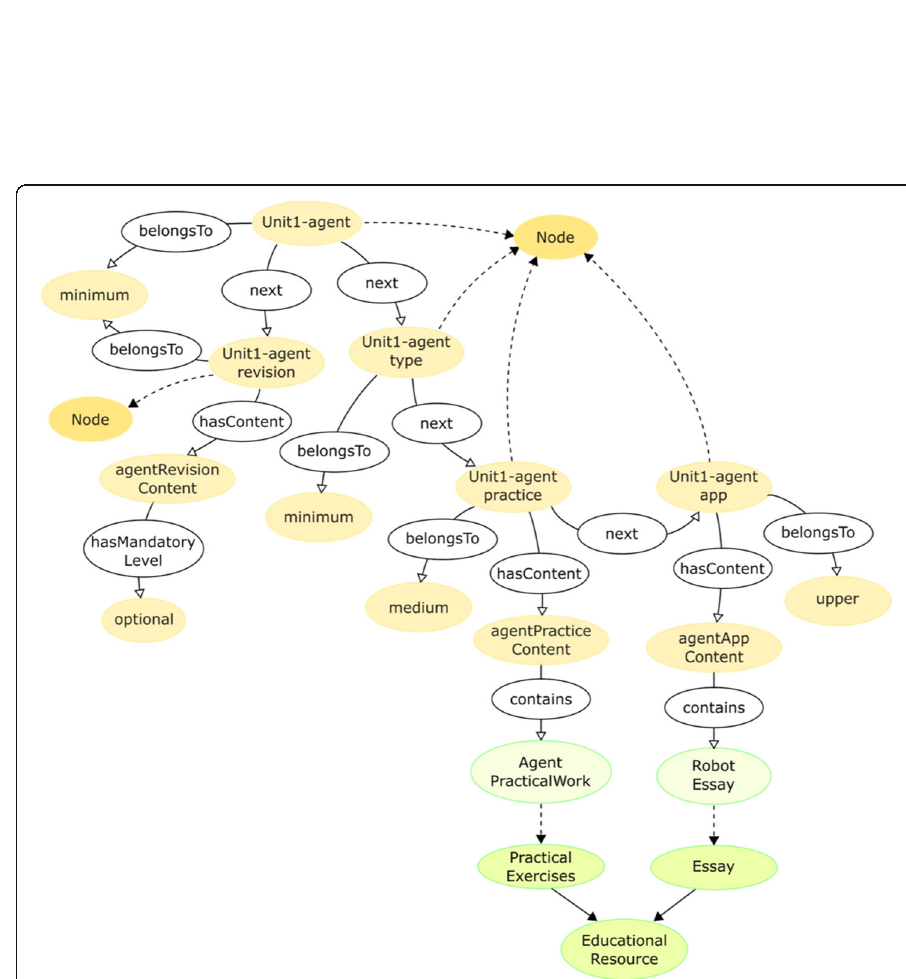
Fig. 8 Example of Learning